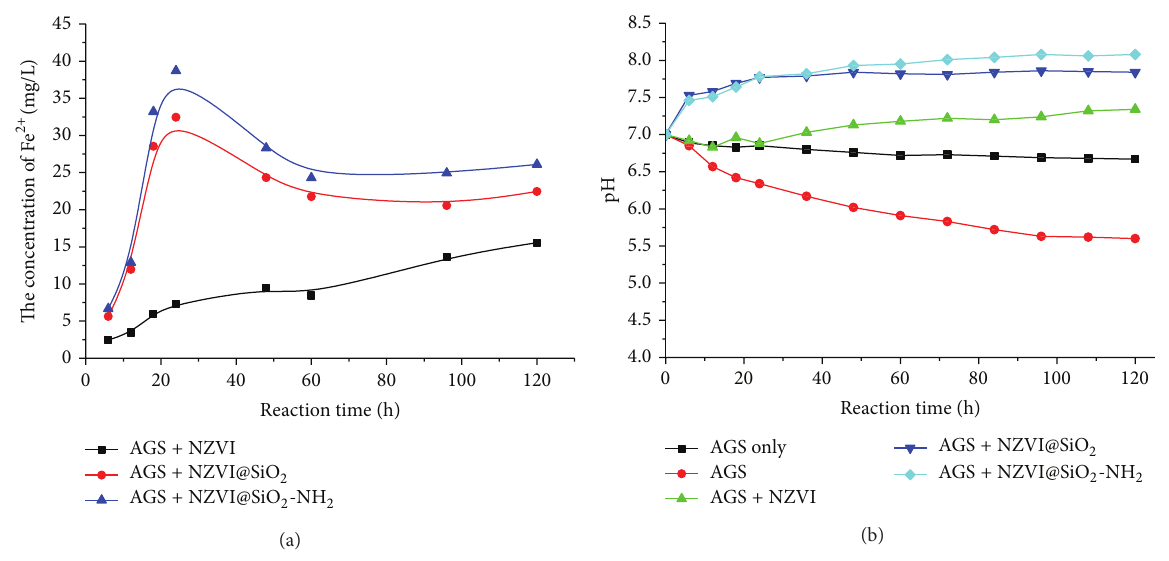
Figure 6: The variation of pH and Fe 2+ during reaction: (a) the concentration of Fe 2+ and total iron and (b) pH.